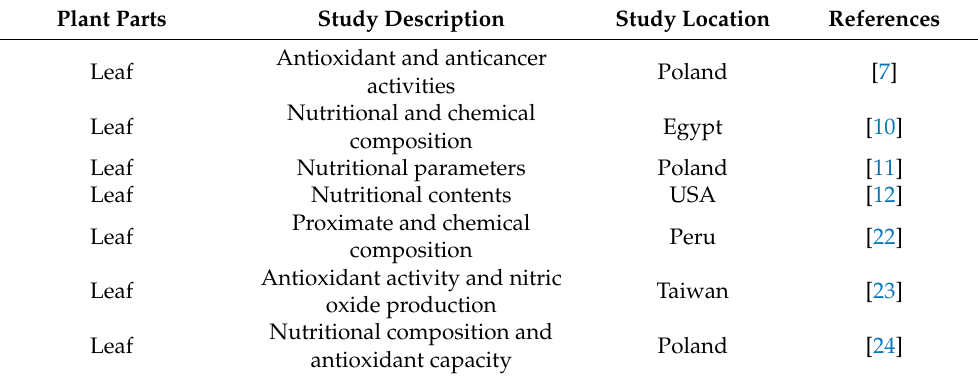
Table 1. Recent studies on nutritional composition and bioactive components in quinoa ( Chenopodium quinoa ) plant parts. Numbers in parenthesis refer to citations of articles of recent studies on quinoa plant parts.